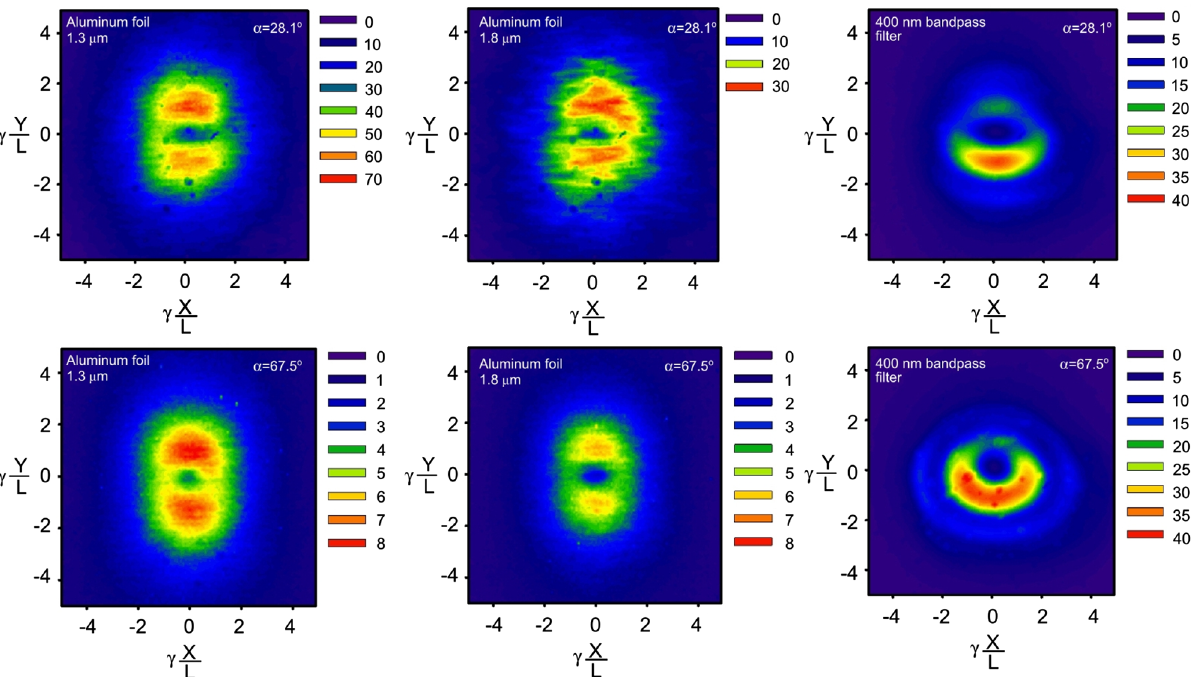
FIG. 4. Examples of BTR spatial distributions in the EUVand optical spectral region, measured with electron beam configuration No. 1; see Table II. Upper row: measurements for a target tilt angle α ¼ 28 . 1 °; lower row: measurements for α ¼ 67 . 5 °. Filters in use (from left to right): Al foil 1.3 and 1 . 8 μ m for observation of EUV radiation and BP filter λ c ¼ 400 nm for observation of visible